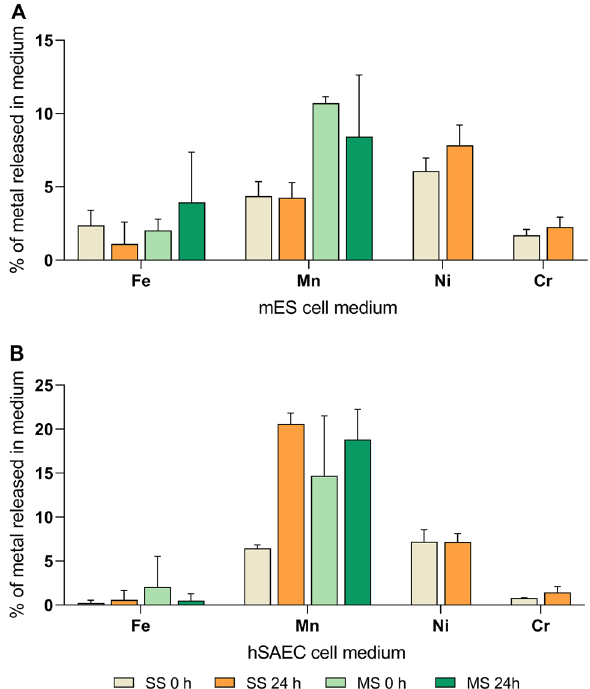
Figure 3. Metal released from welding particles in cell culture media. 50 µg/mL stainless and mild-steel welding particle dispersions were incubated for 24 h with cell medium used for the growth of mES cells ( A ) and hSAEC cells ( B ). The amount of metal (Fe, Mn, Ni, Cr) released in cell medium was analysed by ICP-MS directly after disperson (0 h) and after 24 h. Data was expressed as percentage metal from total metal content in the particles (experimentally determined). Figure created using GraphPad Prism version